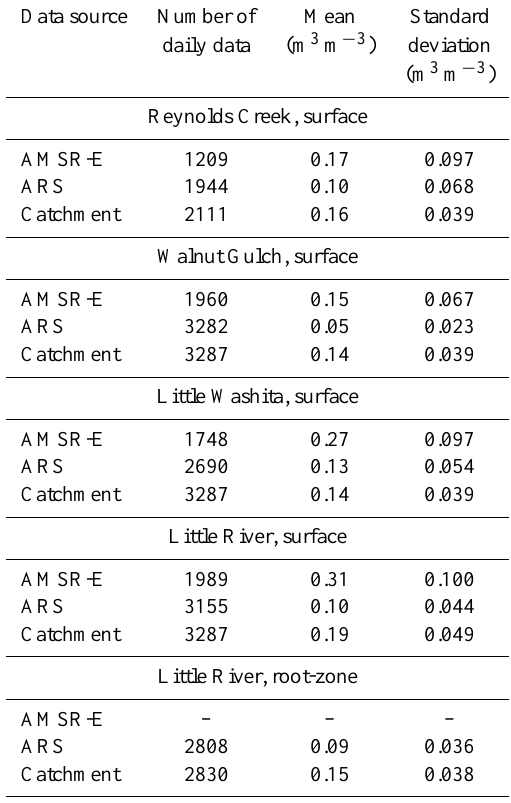
Table 2. Descriptive statistics for the data sets at each